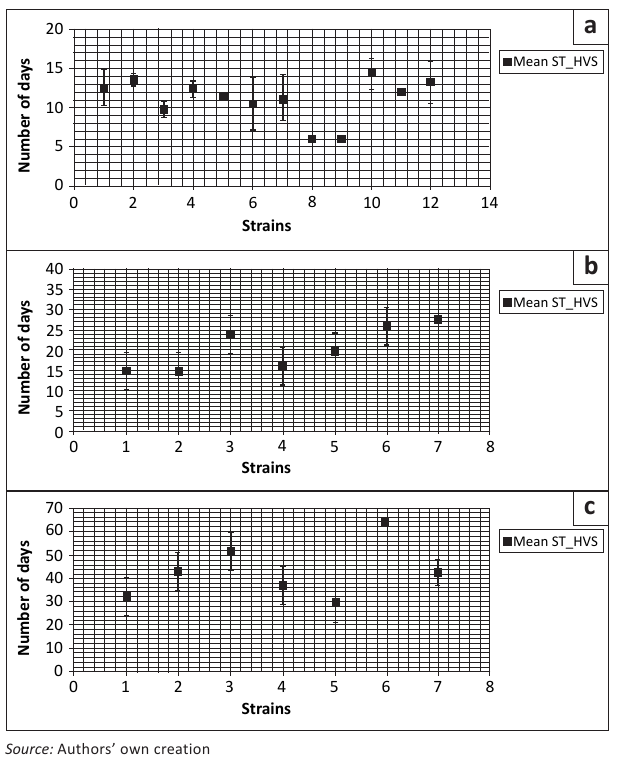
FIGURE 2: Trends in the mean survival time for the (a) high virulence strain ( n = 12), (b) moderate virulence strain ( n = 7) and (c) low virulence strain ( n = 7).